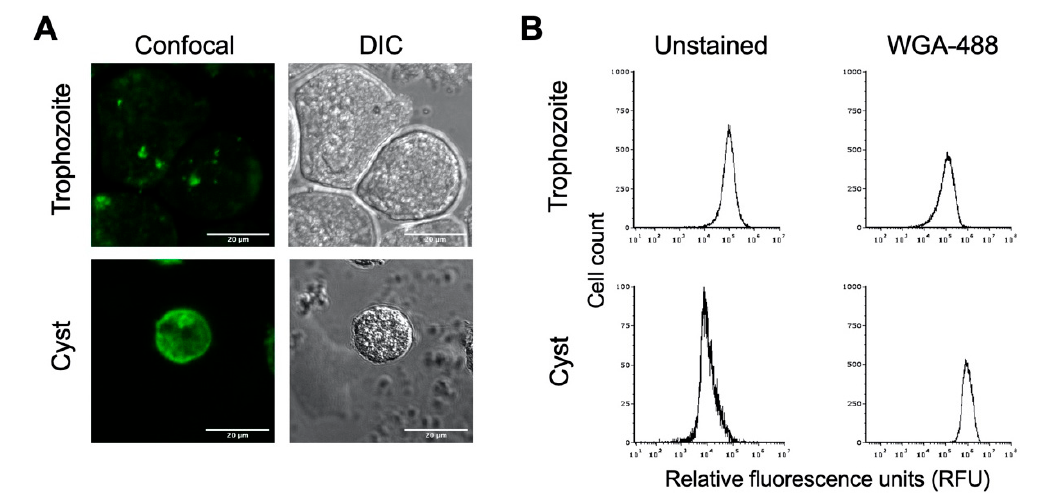
Figure 2. E. histolytica cysts have a chitin cell wall. E. histolytica trophozoites and sarkosyl-treated cysts were stained with AlexaFluor WGA-488 for microscopic visualization and flow cytometry analysis of the presence or absence of a chitin cell wall. ( A ) Representative images of E. histolytica trophozoites (top) and sarkosyl-treated cysts (bottom) stained with WGA-488. Confocal images (left) and their corresponding DIC images (right) are shown with 20 µ m scale bars. ( B ) Flow cytometry analysis of WGA-488-stained trophozoites (top) and sarkosyl-treated cysts (bottom). Histograms on the left are from unstained cells, and those on the right are from cells stained with WGA-488. Histograms display cell count versus relative fluorescence units (RFUs) and are uniform for direct comparison of the position of the peaks. Three biological replicates were performed, and the results shown are representative.